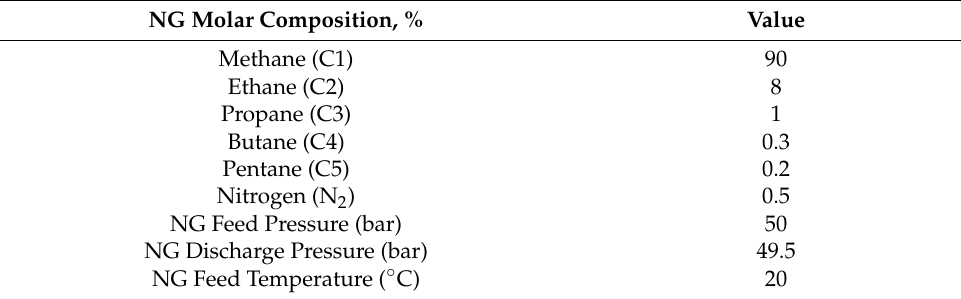
Figure 1. Natural gas liquefaction’s pre-cooling cycle using ammonia-based mixed refrigerants with compounds; ( a ) NH 3 /C1/C2/C3; ( b ) NH 3 /C1/C2/C3/C4–C5. Table 2. Feed natural gas molar composition and